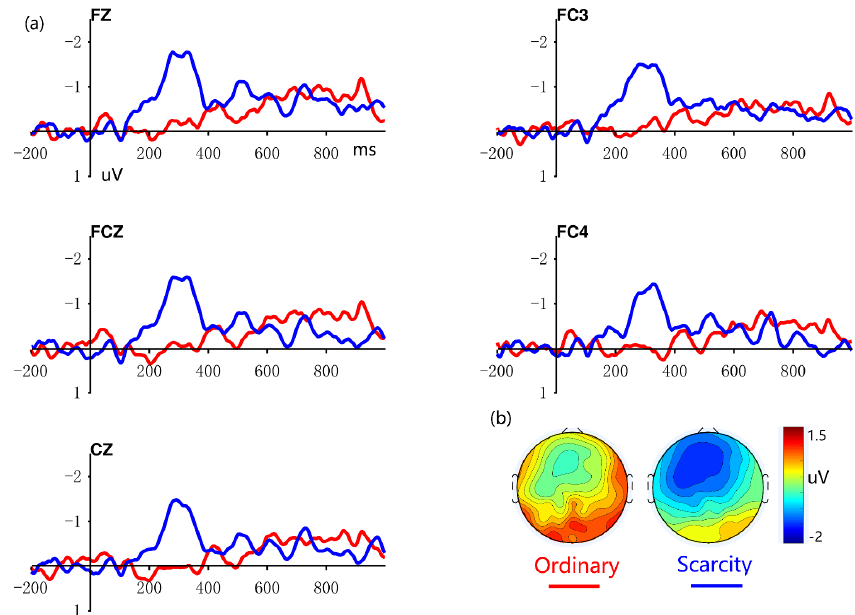
Figure 3. Shows difference waveforms and topographic maps for ordinary and scarcity conditions. The Electrode points Fz, FC3, FCz, FC4, and Cz were selected in panel ( a ). Difference waves were created by subtracting now from future. The red lines represent the ordinary condition, whereas the blue lines represent the scarcity condition. Panel ( b ) indicates the average wave values (uV) during which the dFRN was evaluated (220–270 ms). The left is the ordinary condition, whereas the right is the scarcity condition. Panel B of Figure 4 depicted the result of the FAI. The ANOVA performed on FAI revealed a significant interaction effect of time and reward type, F(1, 43) = 4.283, p = 0.045, part. η 2 = 0.091. Simple effect analysis showed that for the now condition, the scarcity item was associated with greater relative left frontal cortical activity (0.203 ± 0.070) than the ordinary item (0.034 ± 0.065). There was no significant interaction effect between the ordi- nary item (0.120 ± 0.076) and the scarcity item (0.094 ± 0.074), p = 0.76 for the future condi- tion ( p = 0.002). There was no significant main effect of reward type (F(1, 43) = 1.920, p = 0.173, part. η 2 = 0.043) and delivered time (F(1, 43) = 0.006, p = 0.082, part. η 2 = 0.001).